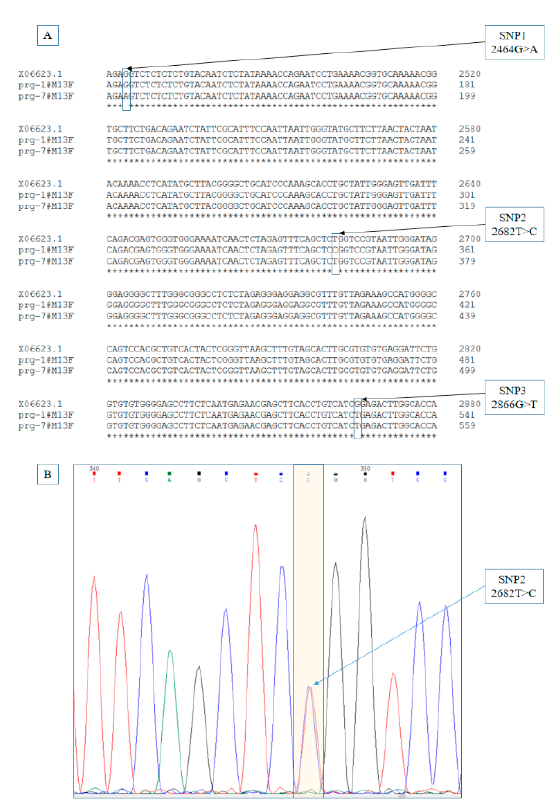
Figure 1. Location of the new single-nucleotide polymorphism (SNP) (2682T > C) in the promoter region of Progesterone Receptor Gene (PRG) sequence.